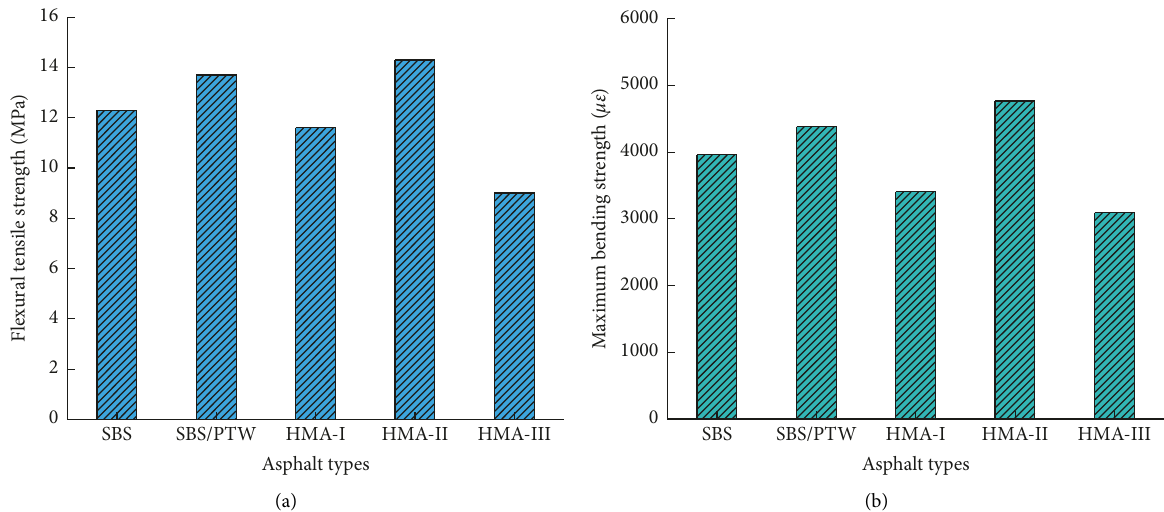
Figure 7: Result of low-temperature bending test. (a) Flexural tensile strength. (b) Maximum bending strength.